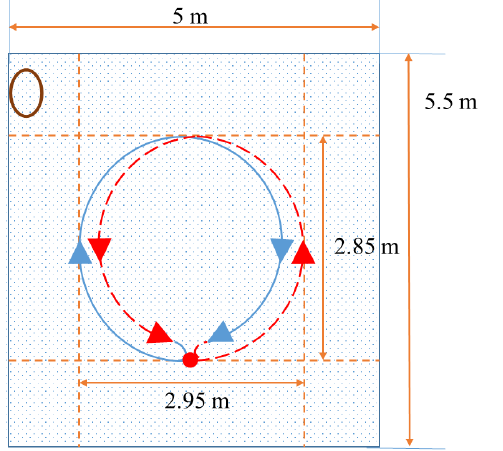
Figure 3. Experiment 1 trajectory shown in test pool.